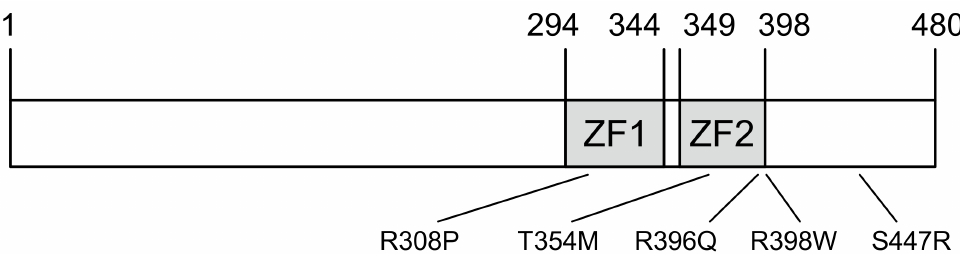
Figure 1. Characteristics of the GATA2 mutations in this study. The domain of human GATA2 protein showing N- and C-terminal zinc fingers (ZF1,